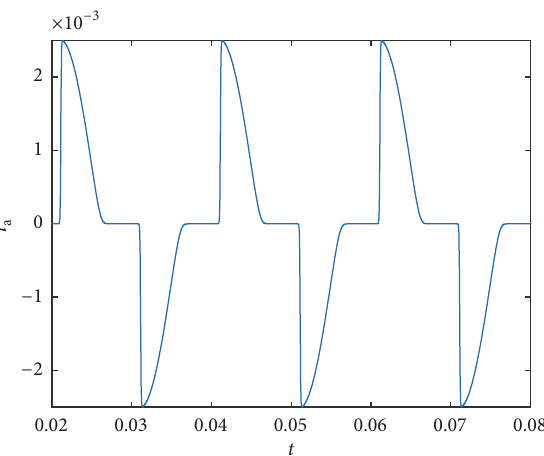
Figure 13: Locus in v - i plane.